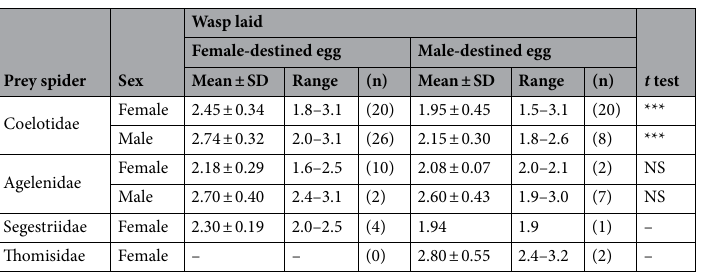
Table 3. Comparison of the cephalothorax width (mm) of the prey spiders on which Dipogon sperconsus laid eggs. ***Indicates the significance level at p < 0.001.